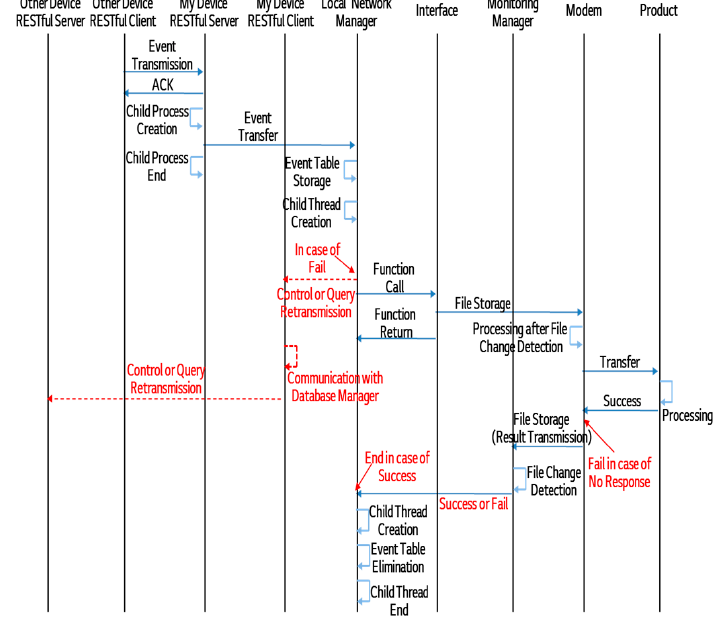
Figure 5. Protocol for receiving and processing events.